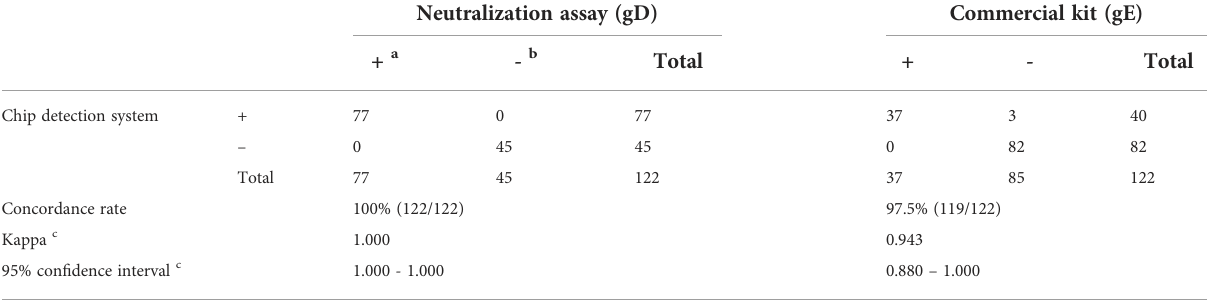
TABLE 2 Comparison of the chip detection system, neutralization assay and commercial PRV gE antibody detection kit for gD and gE antibody detection of clinical